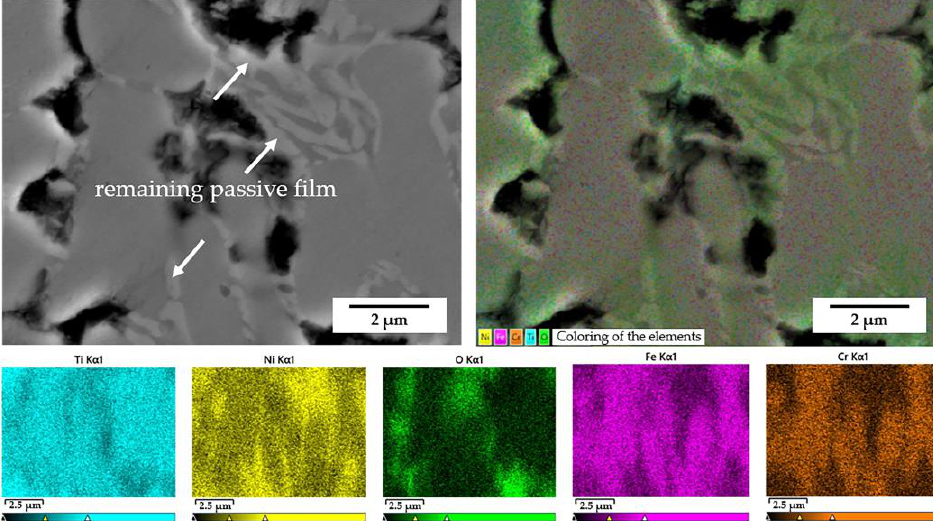
Figure 17. EDS regional scanning results for the 55NiTi coating after corrosion.